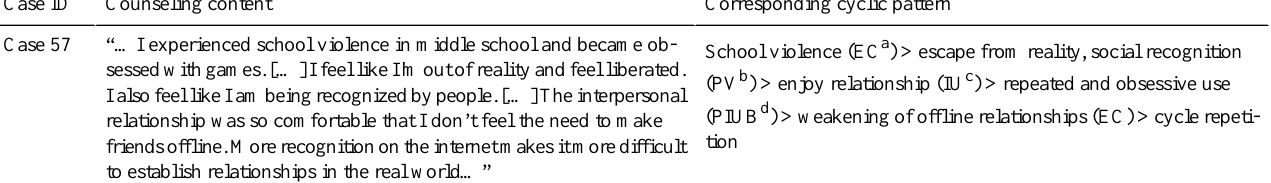
Table 4. Representative counseling cases that show the cyclic reinforcing process.